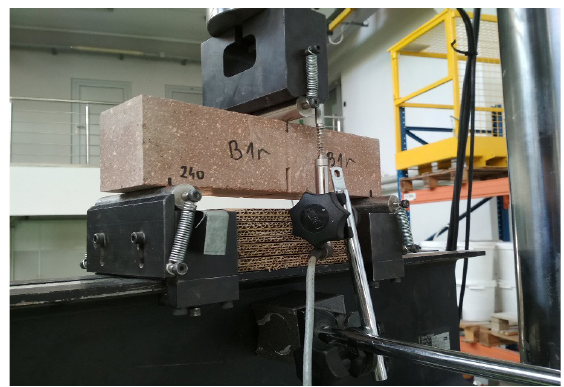
Figure 7: Three point bending test for notched